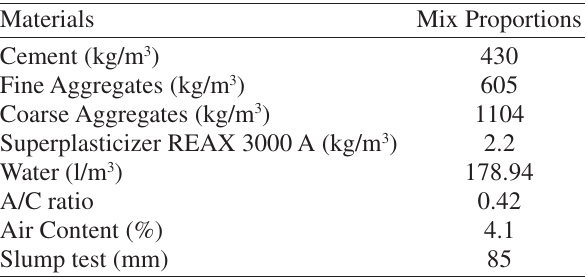
Table 2. Typical Mix Proportions for Strength Group C40 Con- crete.